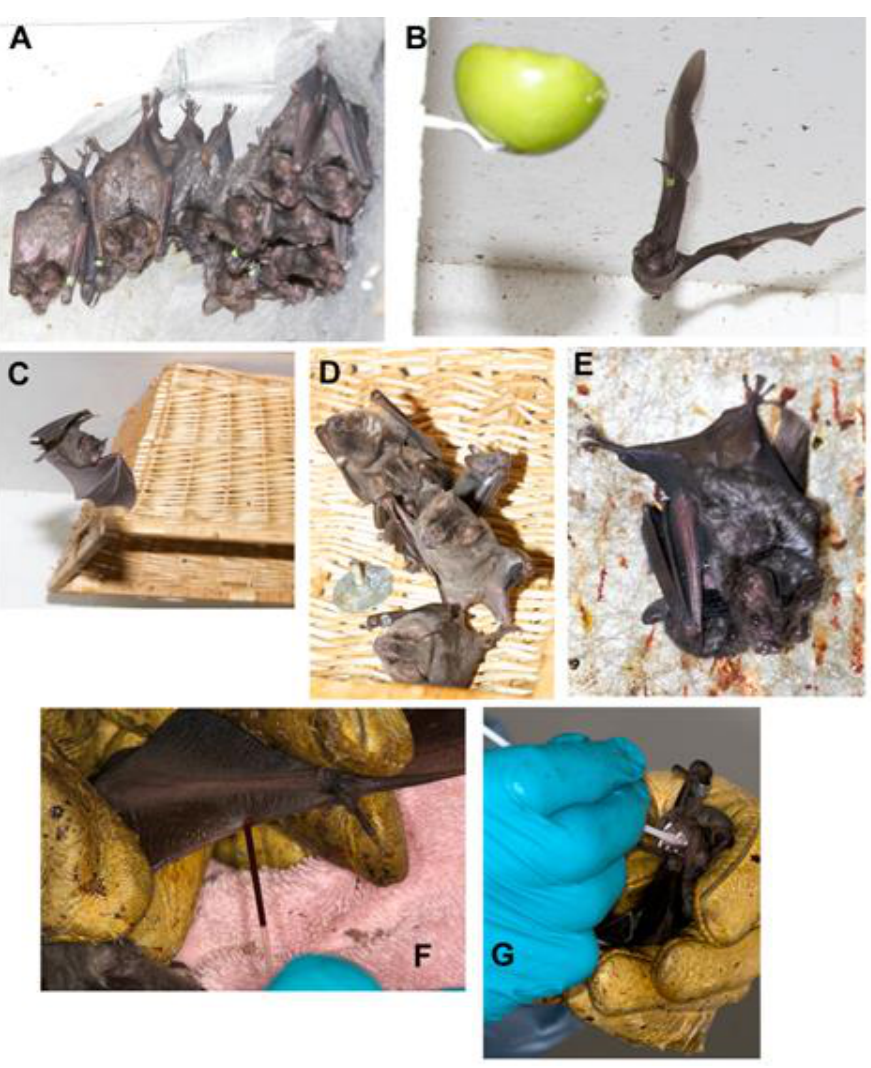
Figure 1. Bat husbandry and manipulations. Establishment of bat colonies for experimental research requires enrichment for successful maintenance and reproduction. ( A ) Landscape fabric attached to walls provides roosting substrate; ( B ) Hanging of fruit on skewers can provide enrichment for frugivorous bats by stimulating foraging behavior. A wing band (green) is present with a unique identification number; ( C , D ) Hanging of inverted wicker or metal baskets provide additional roosting substrates; ( E ) A female Seba’s fruit-eating bat ( Carollia perspicillata ) with offspring; ( F ) Blood collection from a bat wing; ( G ) Oral swab for virus collection. Photos are by the author and are of the colony at the University of Northern Colorado